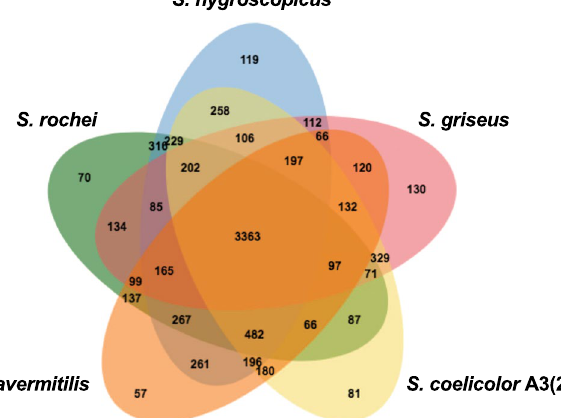
Figure 4. Venn diagram of the number of shared and unique genes between S. rochei and four other Streptomyces strains. OrthoVenn, a web-based application (http://www.bioinfogenome.net/OrthoVenn/) was used in this analysis. Other Streptomyces strains used in this analysis are S. coelicolor A3(2), S. avermitilis MA- 4680, S. griseus IFO13350, and S. hygroscopicus